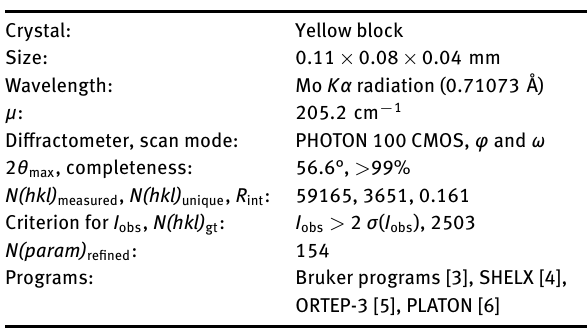
Table 1: Data collection and handling.